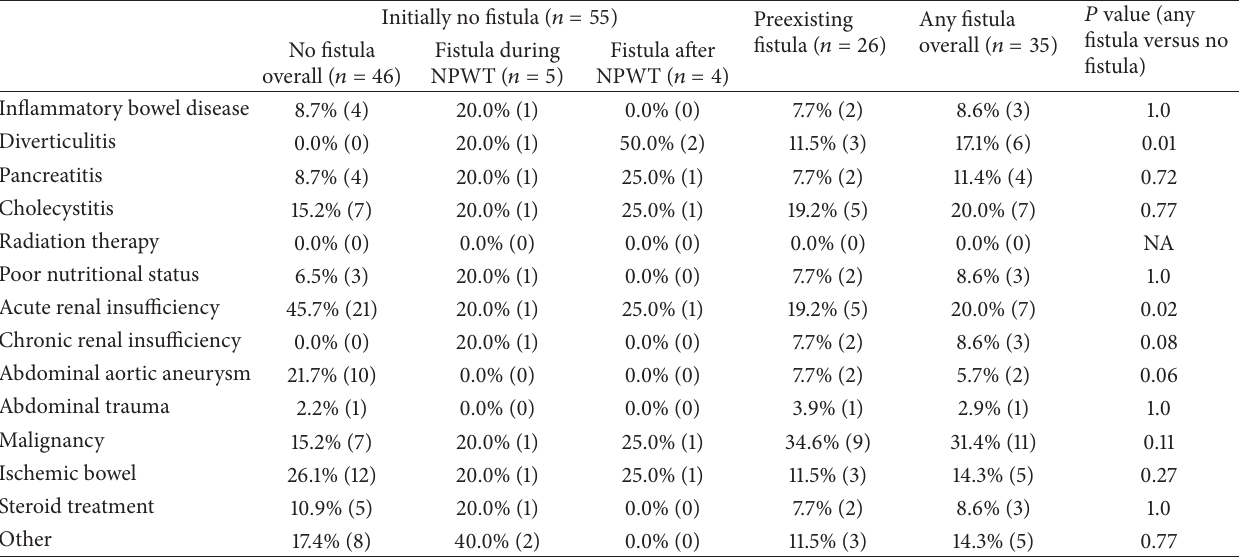
Table 3: Predisposing